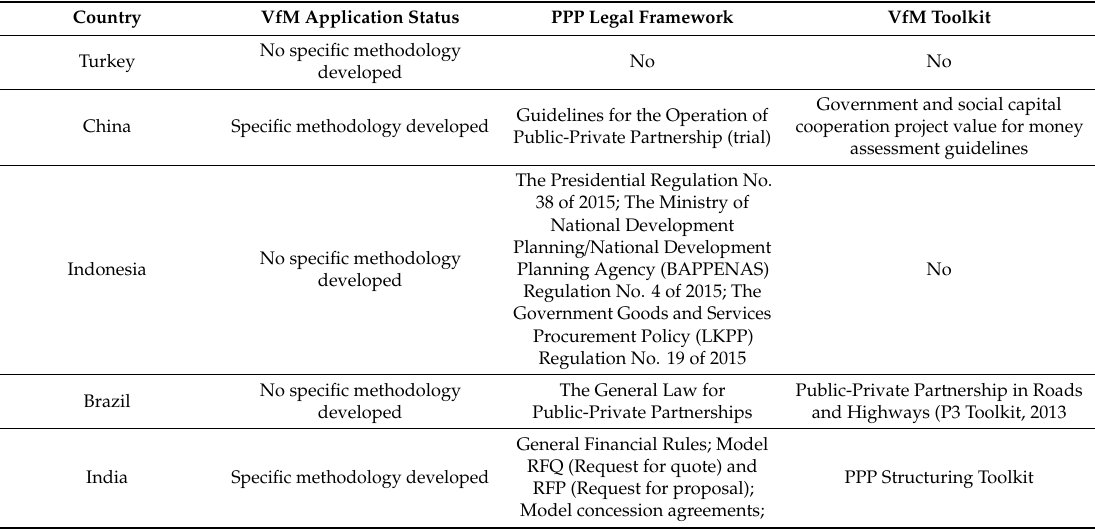
Table 3. Value for money (VfM) application status in major PPP countries